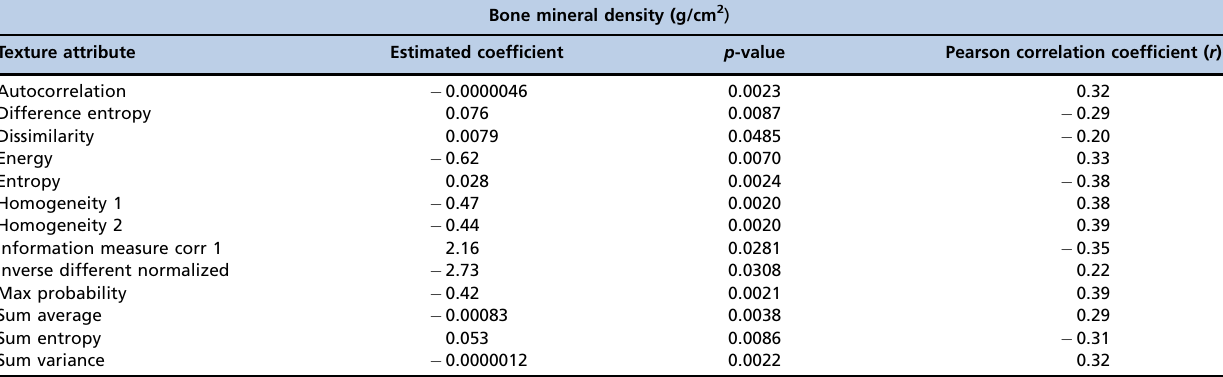
Table 2 - Estimated coefficients of the association between bone mineral density and bone texture attributes. Bone mineral density (g/cm 2 ) Texture attribute Estimated coefficient Pearson correlation coefficient ( r